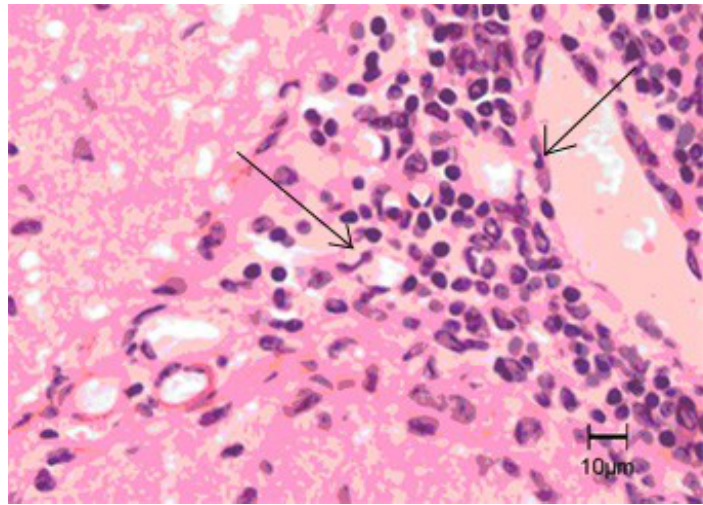
Figure 6: An inflammatory focus with neutrophils (arrows) in AIRmax mice infected with AgV3.